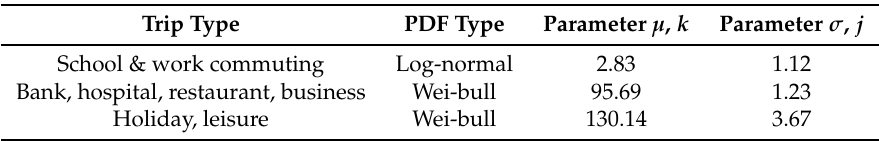
Table 1. PDF parameters for different trips.